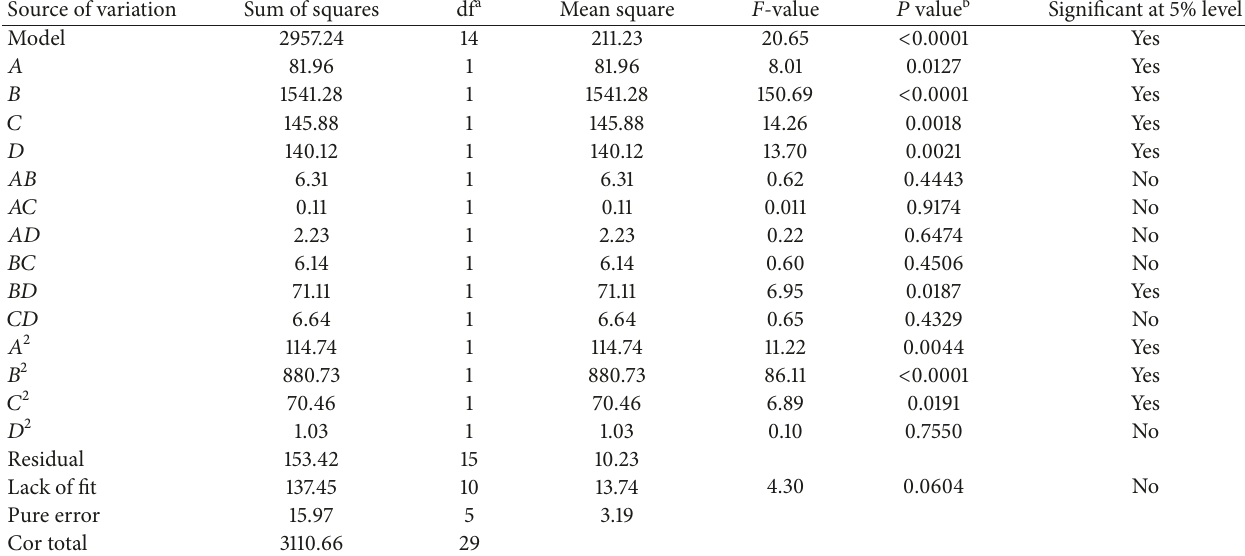
Table 3: ANOVA for the response surface quadratic model.